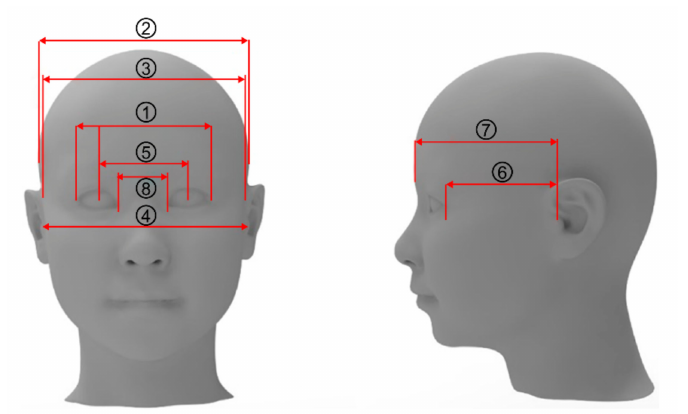
Figure 1. 3D head measurement